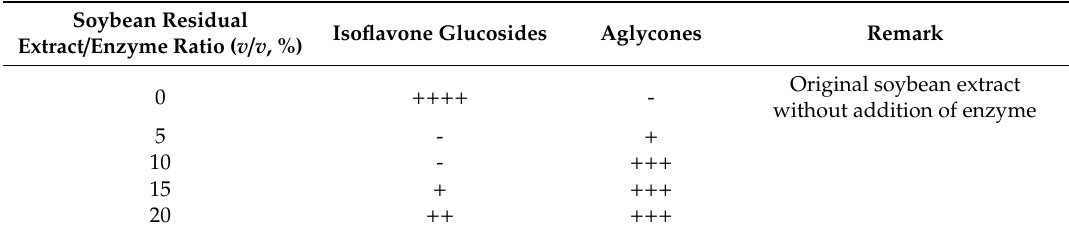
Table 2. E ff ect of volumetric ratio of soybean residual extract / enzyme on isoflavone glucosides and aglycones formation by P. citrinium at 30 ◦